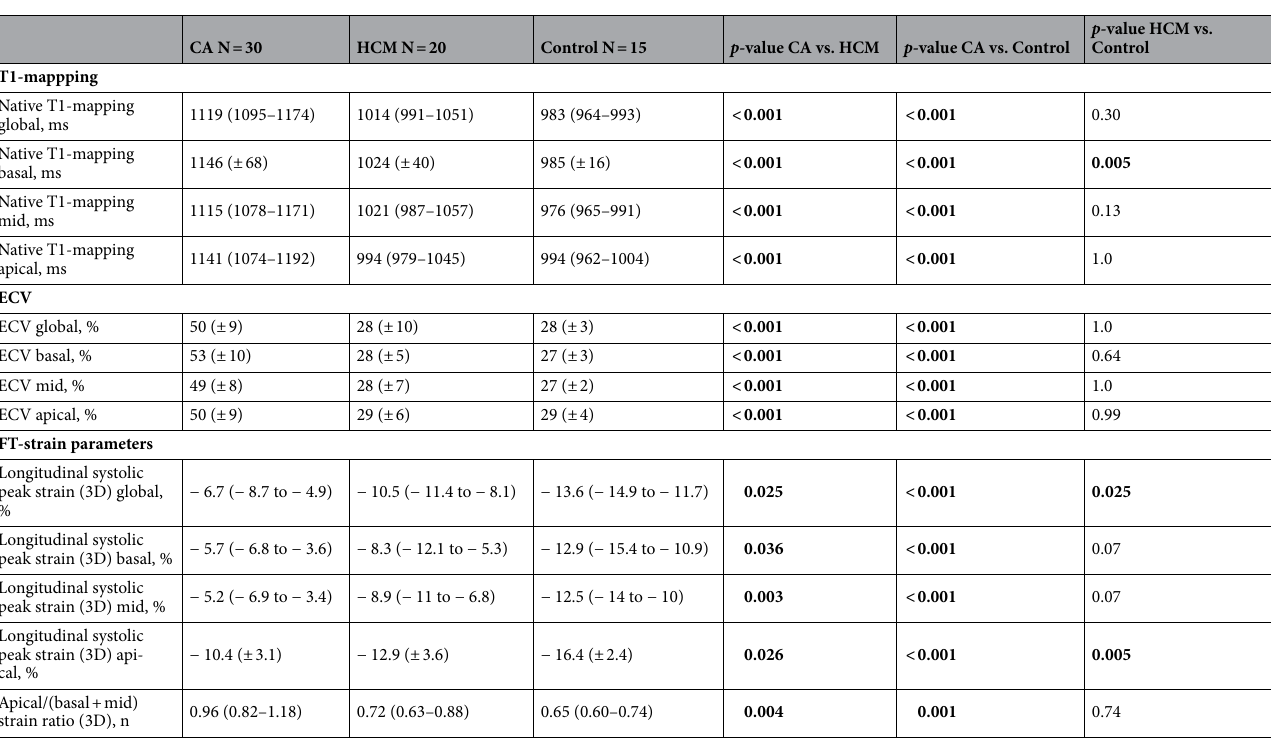
Table 3. Novel CMR parameters. Bold values indicate significant p -value <